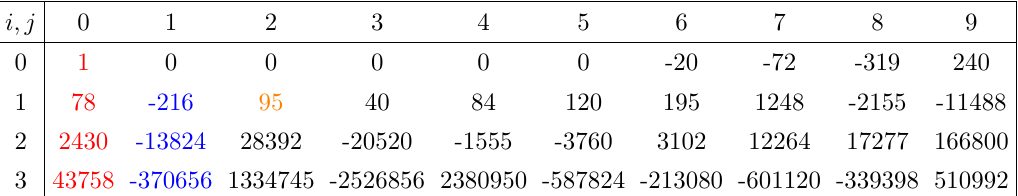
Table 14 . Series coefficients c i,j for the one-string elliptic genus of n = 2 E 6 model.